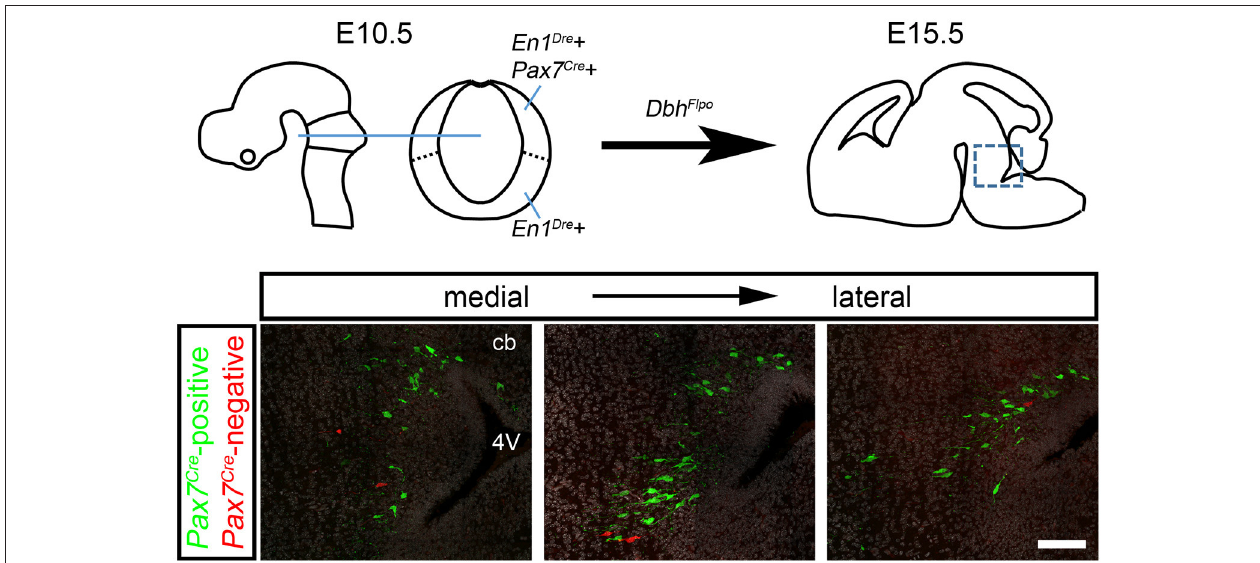
FIGURE 2 | A subpopulation of r0- and r1-derived noradrenergic neurons does not come from the Pax7 Cre -defined alar plate. Schematic diagrams show the mouse brain at E10.5 and E15.5. On the sagittal schematic of E15.5 brain, the box indicates the approximate position of immunofluorescent images shown below. In fluorescently labeled parasagittal sections of an E15.5 En1 Dre ; Dbh Flpo ; Pax7 Cre ; RC::RFLTG quadruple heterozygous embryo, the majority of r0- and r1-derived noradrenergic neurons are labeled with eGFP, indicating a history of Pax7 Cre expression. At several different points along the mediolateral axis, a few neurons are labeled with tdTomato, indicating an origin outside the Pax7 Cre -defined alar plate. DAPI staining (false colored gray) reveals tissue that is not otherwise stained. cb, Cerebellum; 4V, fourth ventricle. Scale bar: 100 µ m.